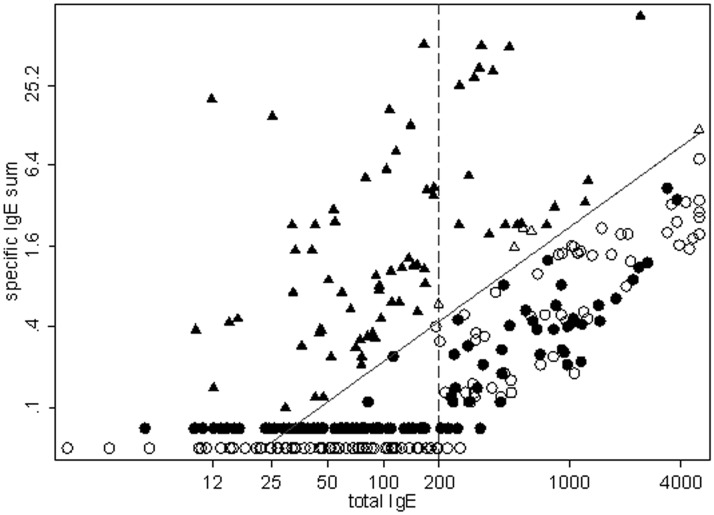
Scatterplot of the sum of β-lactams vs. total IgEs.Both axes are on the log scale, enabling to plot the ratio index values as a straight, oblique line, given that the ratio of two variables equals a linear difference in their logs. Black filled symbols are reactive patients and empty symbols are non-reactive subjects. Triangles are subjects with specific/total IgE ratio above 0.002 and circles are those below this level. Subjects with non-measurable sum of β-lactam IgEs are plotted in two lines parallel to the x axis and below the detection threshold of 0.10 kUA/l. It can be seen that the subjects above the ratio are nearly all reactive or true positives (black triangles), while a substantial amount of false positives (black circles) is found below this ratio threshold for subjects with total IgE above 200 kU/l.